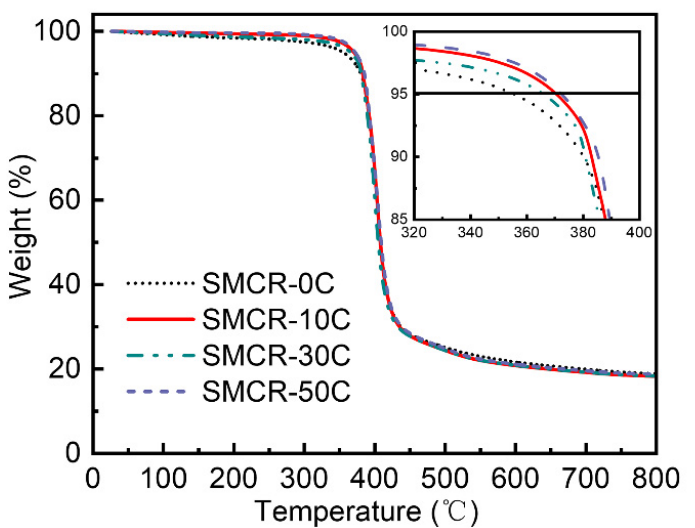
Figure 2. Thermal gravimetric (TGA) curves of SMCR before and after vacuum thermal cycling.